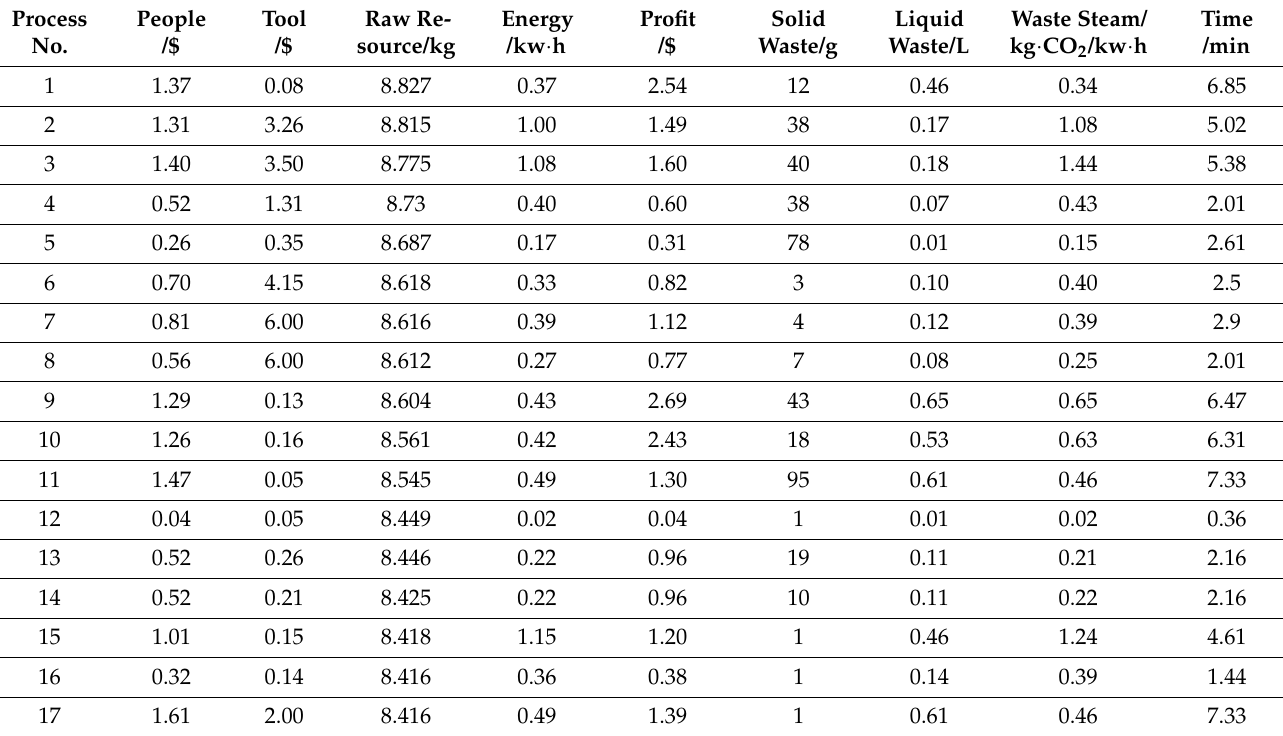
Table 3. The input and output indexes of each machining process